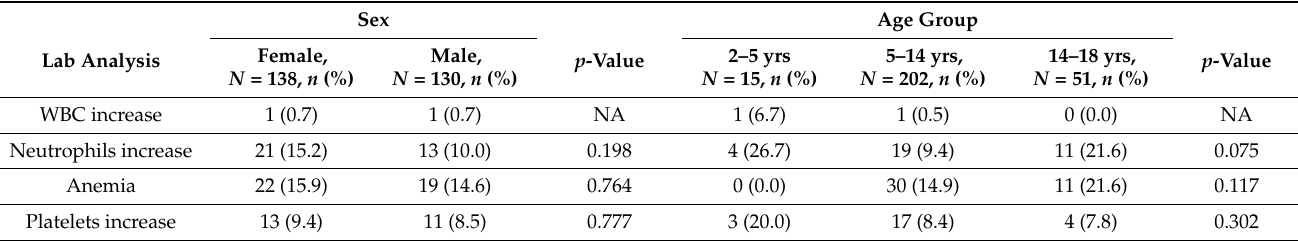
Table 3. Laboratory findings according to sex and age